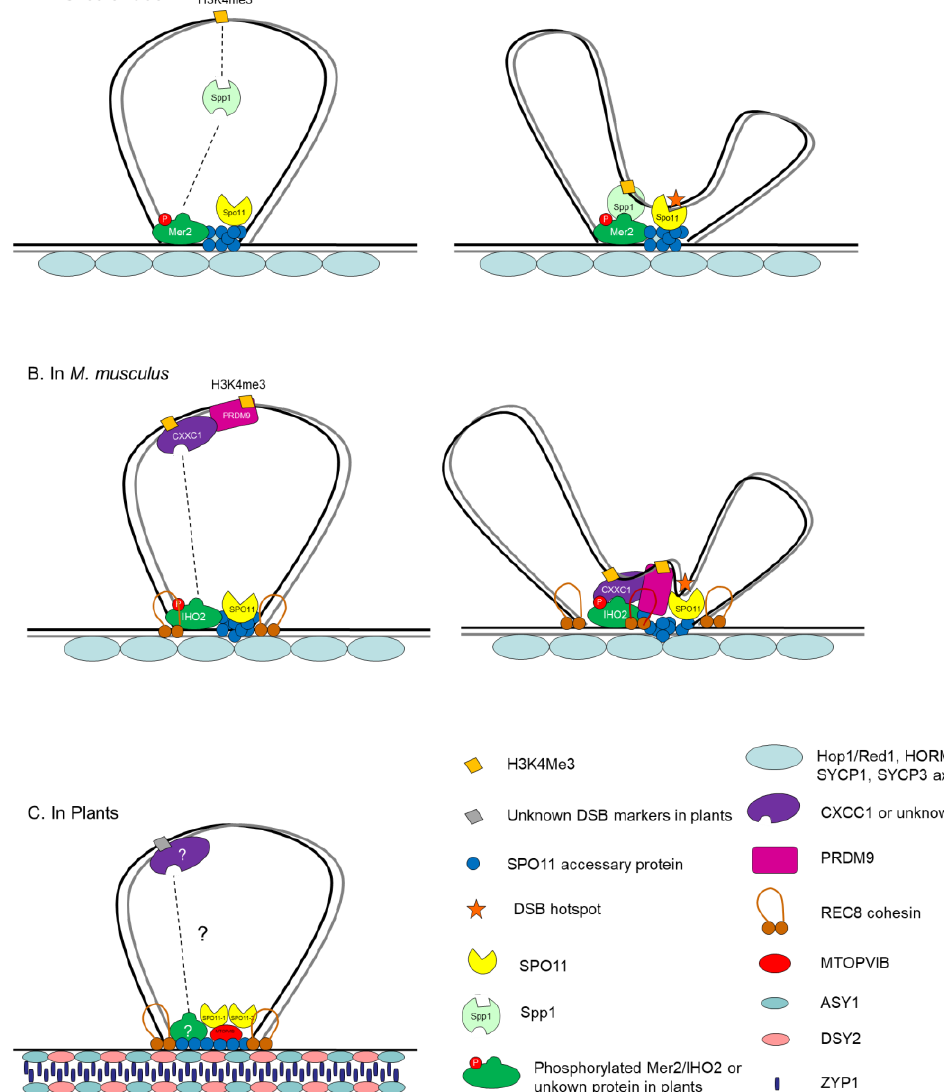
Figure 2. Different ‘tethered loop–axis complex’ models in S. cerevisiae , M. musculus and plants. ( A ) In S. cerevisiae , Spp1 recognizes and binds to DSB hotspots adjacent to H3K4me2/3 on loops via interaction with axis-bound Mer2 [55,161,162] . ( B ) In M. musculus , CXXC1 interacts with PRDM9 and IHO2, which designates DSB hotspots in loops and is located on chromosome axes, respectively; this interaction tethers the chromatin loop to the axis for DSB formation [158,163–166]. ( C ) In plants, the major players involved in bridging chromatin loops with axis remain uncharacterized